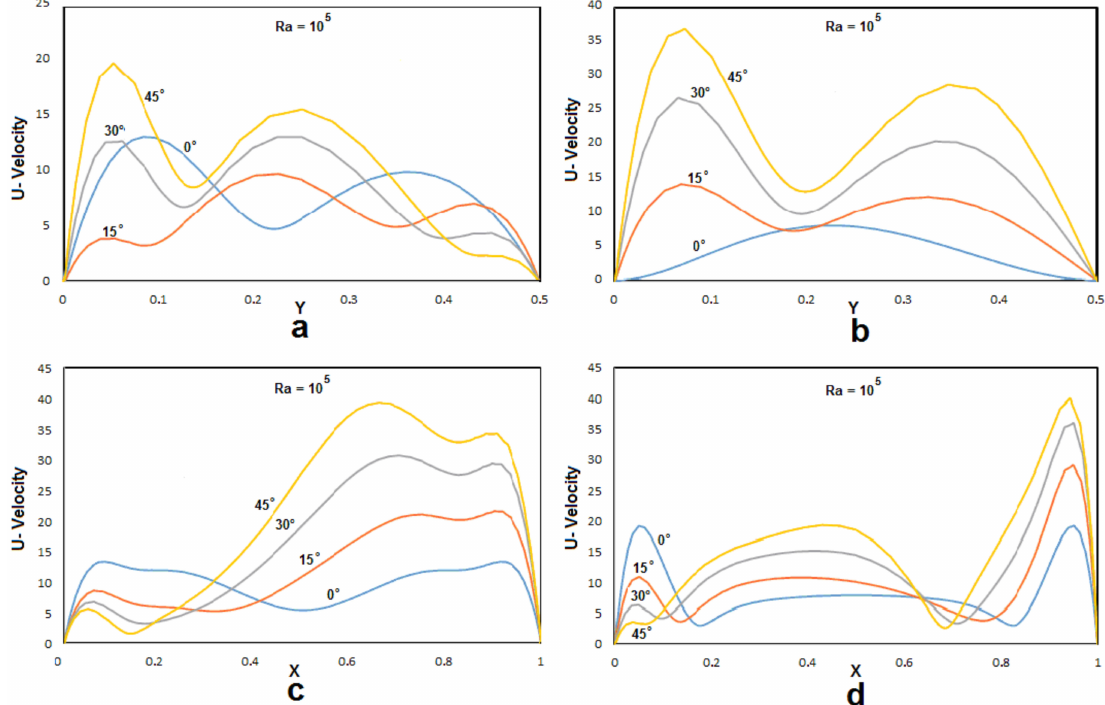
Figure 7. Nanofluid velocity evolutions at the levels: X = 0.25 ( a ) X = 0.5 ( b ) Y = 0.25 ( c ) Y = 0.5 ( d ) for a Rayleigh number Ra = 10 5